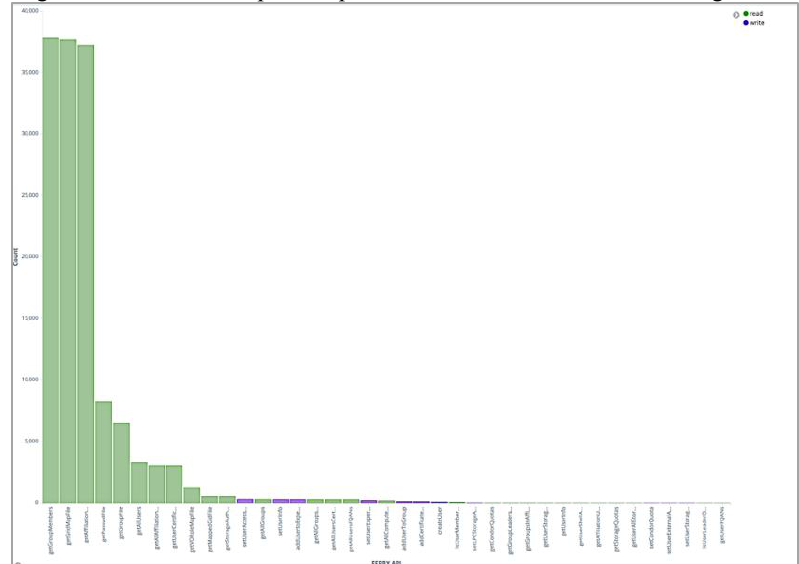
Fig. 5. Weekly graph of FERRY activities by API requests using